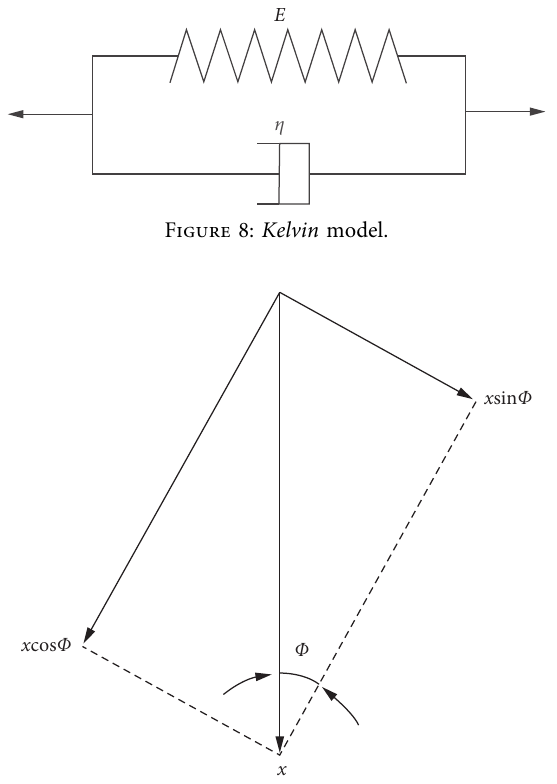
Figure 8: Kelvin model.